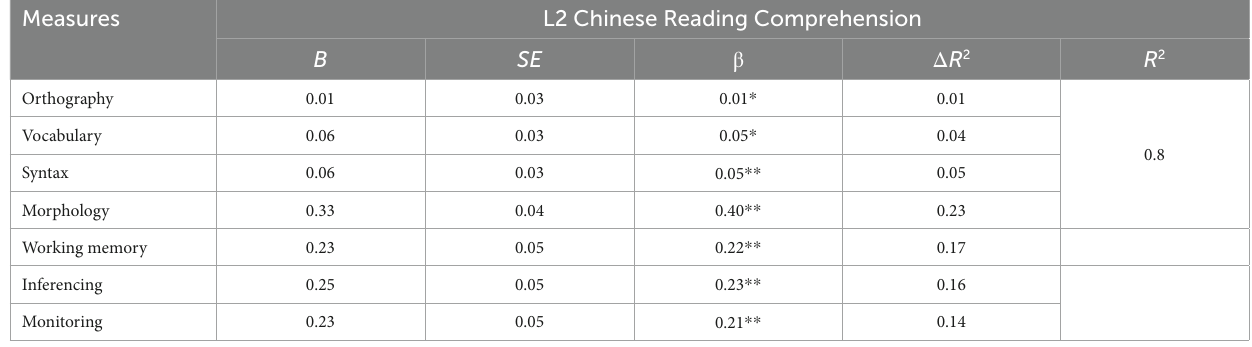
TABLE 2 Hierarchical multiple regression of the model predictors on reading comprehension.